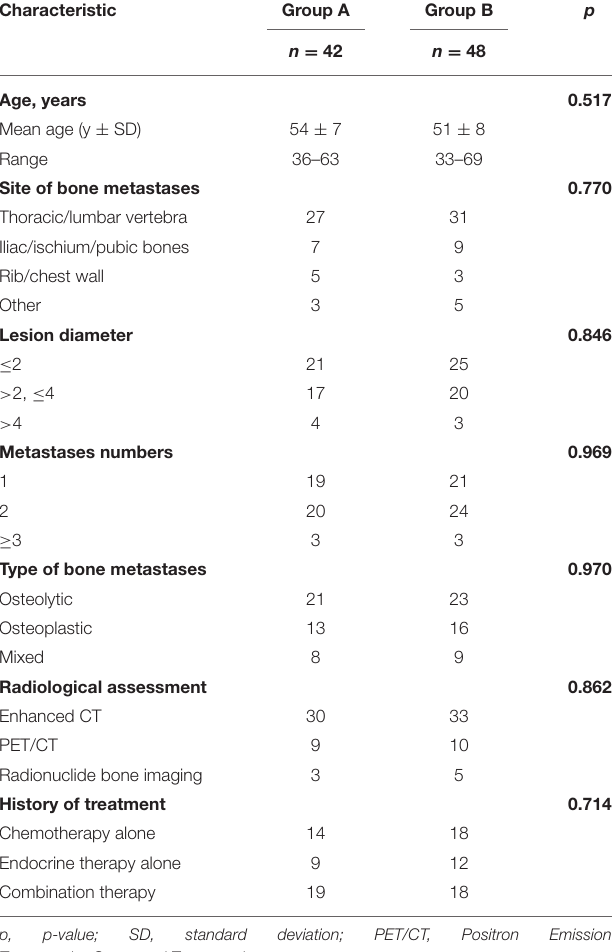
TABLE 1 | Clinical characteristics of the patients and